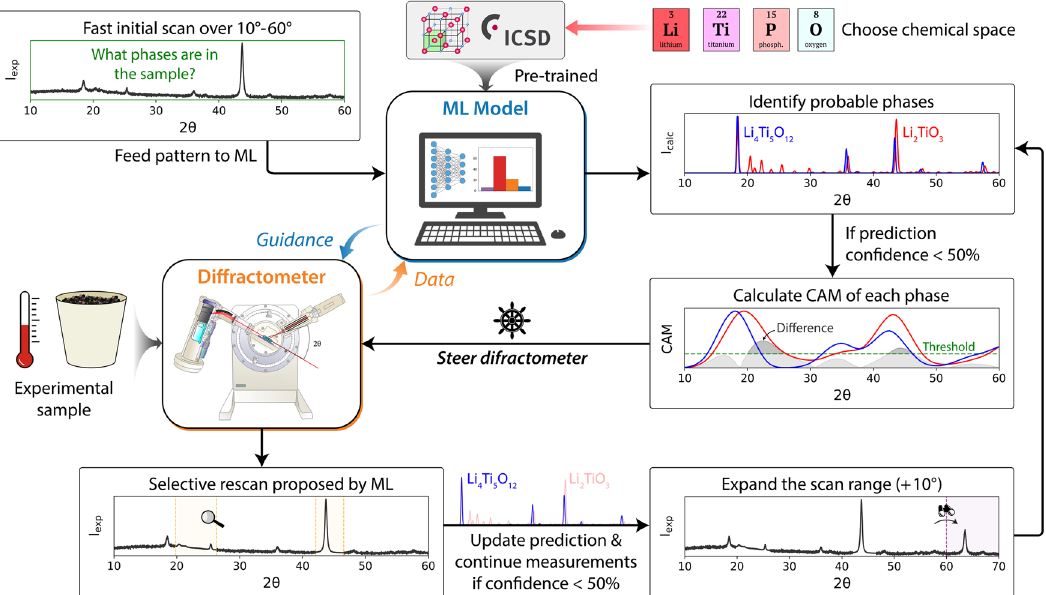
Fig. 1 A schematic for adaptively driven XRD with autonomous phase identi fi cation. After performing a fast initial, the resulting XRD patten is fed to a pre-trained ML model which proposes likely phases. If the con fi dence associated with any of these phases low (< 50%), the diffractometer is instructed to perform selective rescans around peaks that distinguish the suspected phases. If necessary, the scan range is also expanded to detect additional peaks and boost the prediction con fi dence of the ML